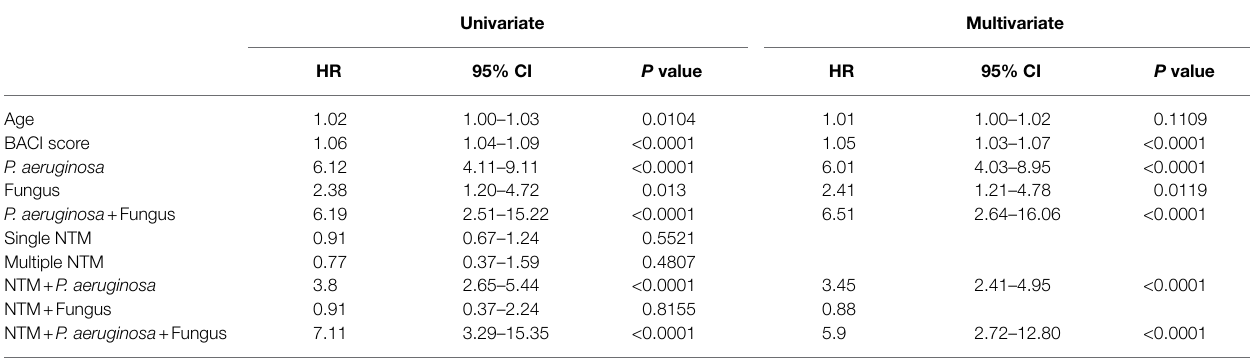
TABLE 2 | Hazzard ratio of ventilator use according to different pathogen isolates from